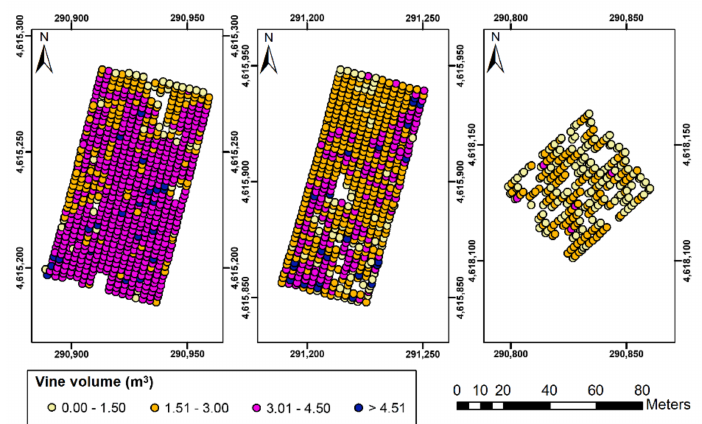
Figure 8. Four-level representation of the estimated vine canopy volume as computed on the three fields in July, from left to right: From left to right: Field A, Field B, and Field C. In the axes, coordinate system UTM zone 31 N, datum WGS84.